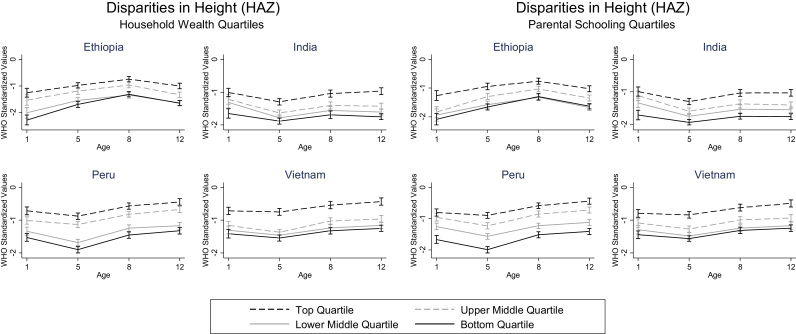
Disparities in HAZ from household wealth and parental schooling are fairly parallel, Young Lives study. HAZ is standardized according to World Health Organization international norms.